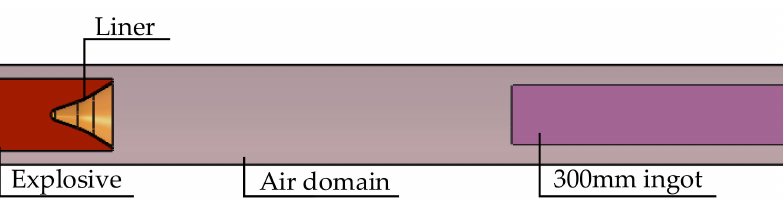
Figure 2. Structural model of penetration into the control cabin and target plate.